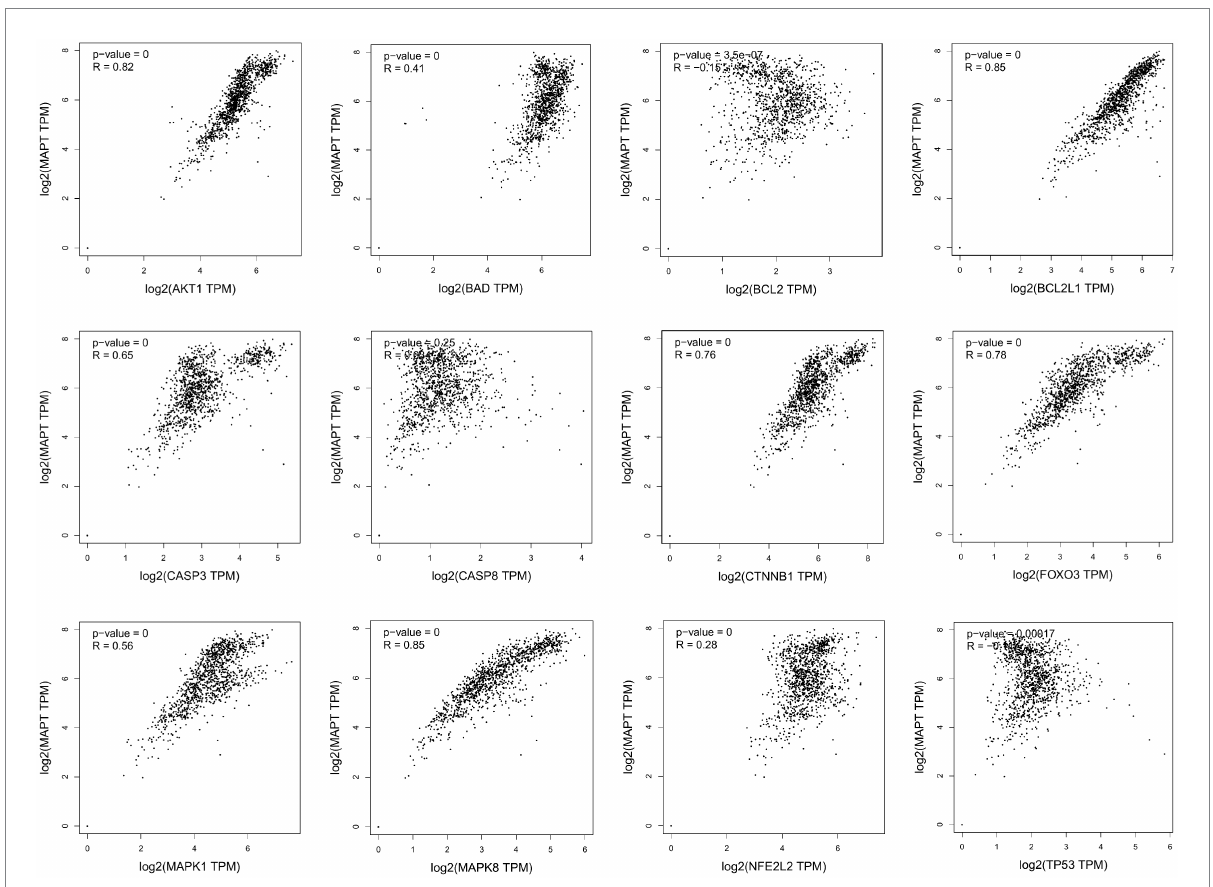
FIGURE 6 Analysis of the correlation between 12 key targets of Cordycepin and the pathogenic gene of Alzheimer’s disease